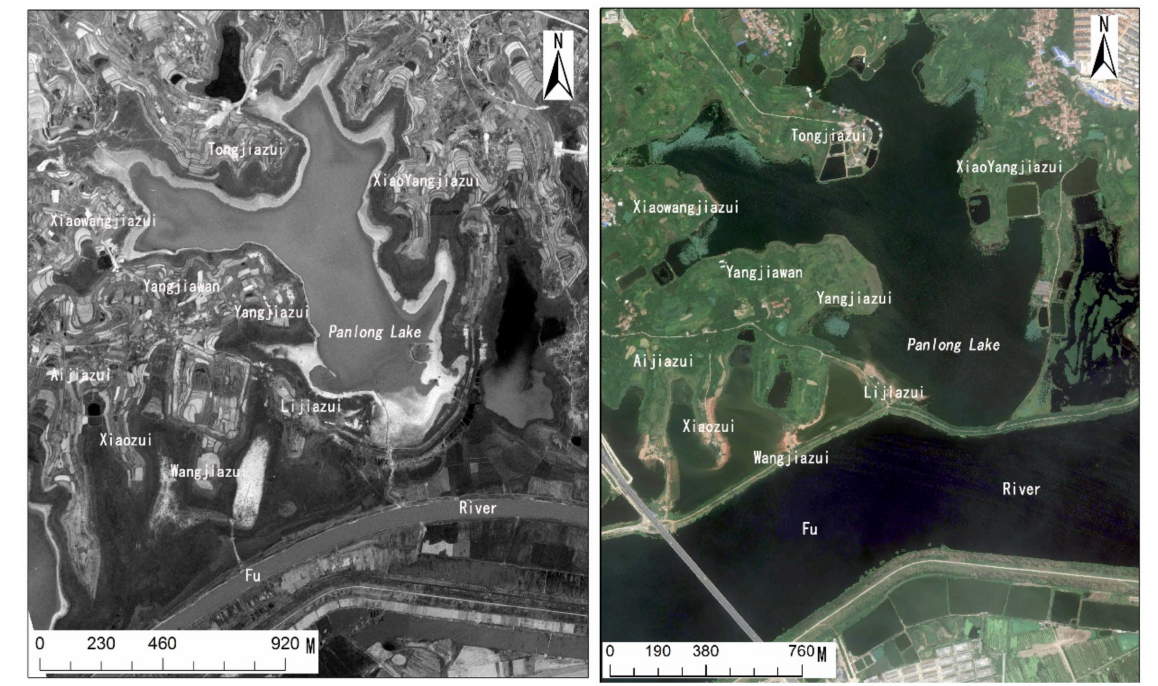
Figure 2. Satellite images of Panlongcheng ( Left 1962; Right